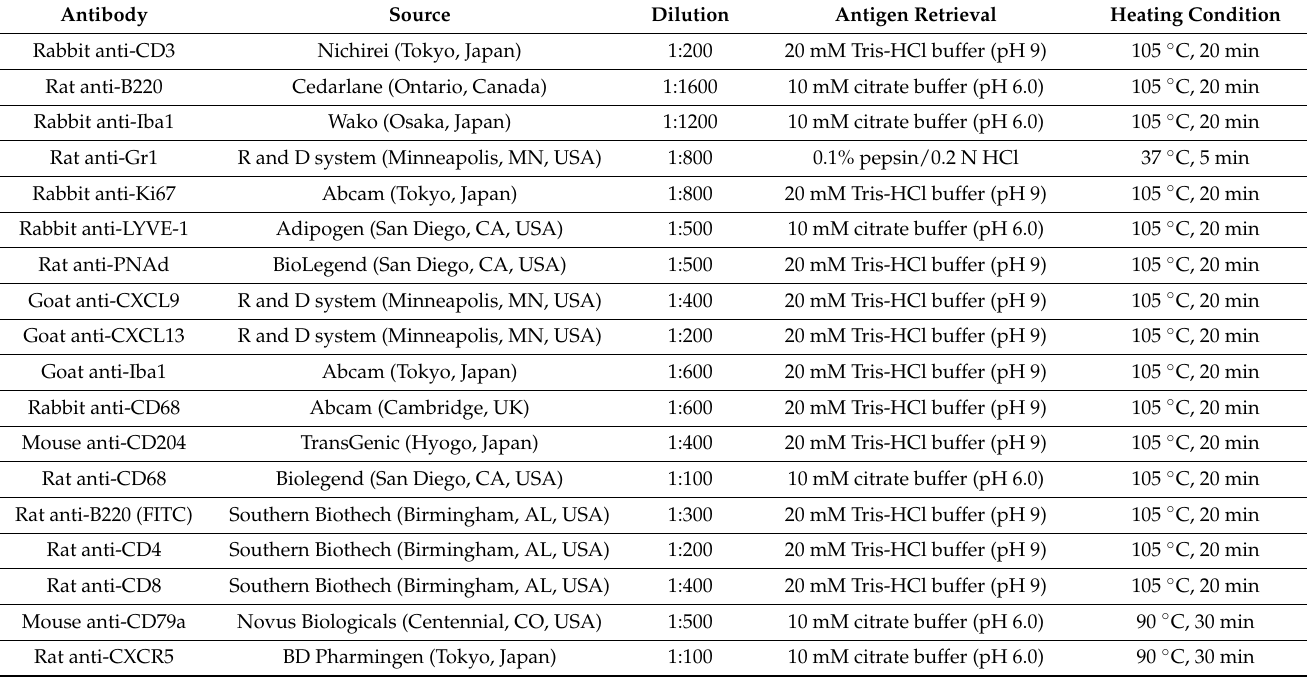
Table 1. List of antibodies, source, working dilutions, and conditions for antigen